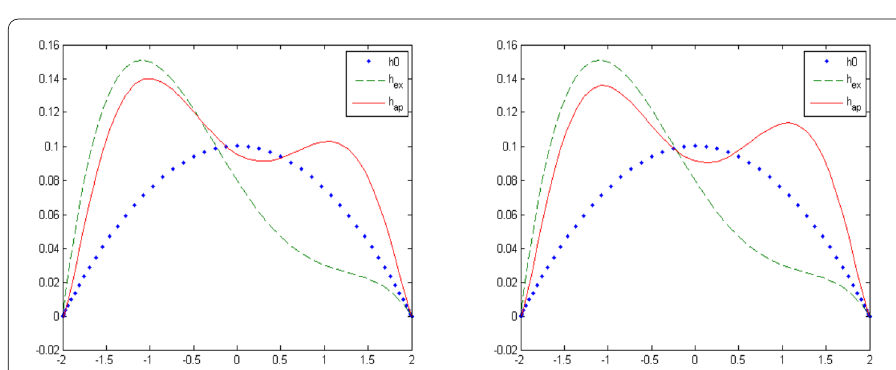
Figure 9 Reconstruction of h 3 after one iteration for exact data (left), and noisy data with δ = 0.01